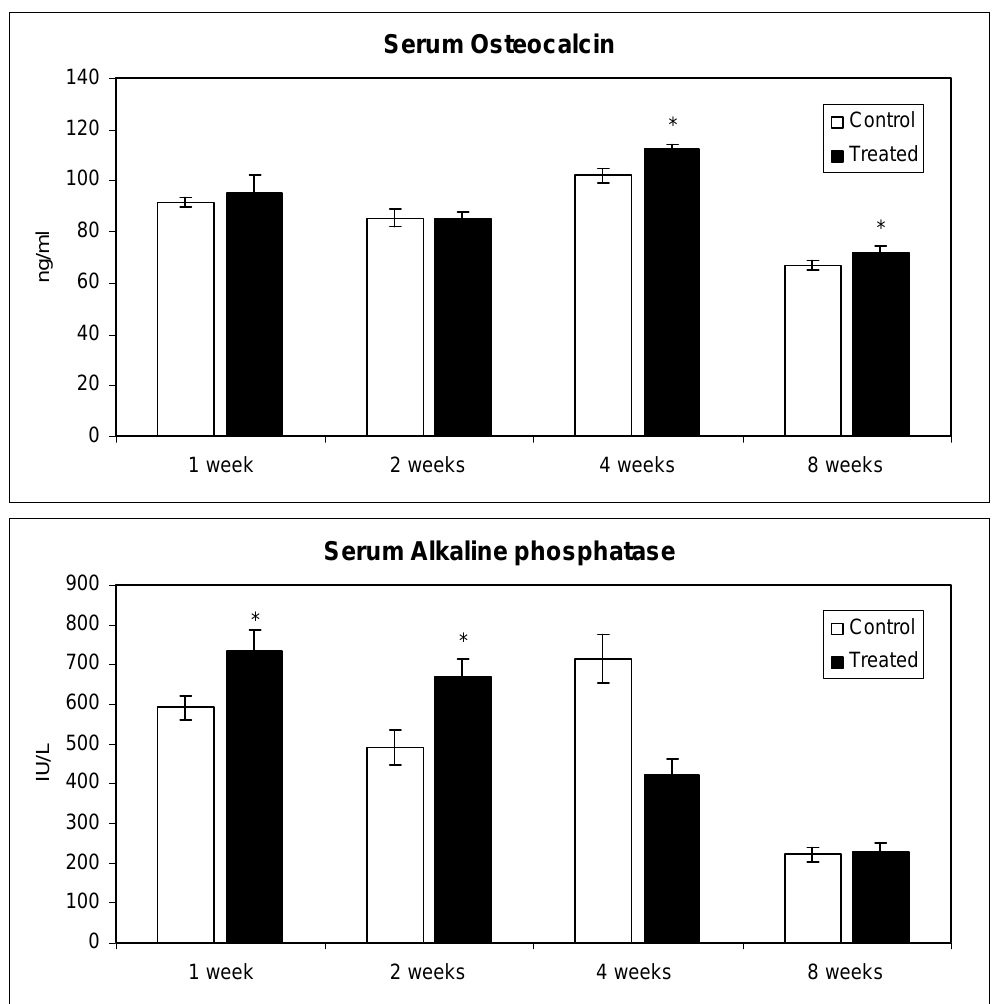
Figure 2. Concentration of osteocalcin and bone-specific alkaline phosphatase in serum after oral administration of Carthamus tinctorius extract.